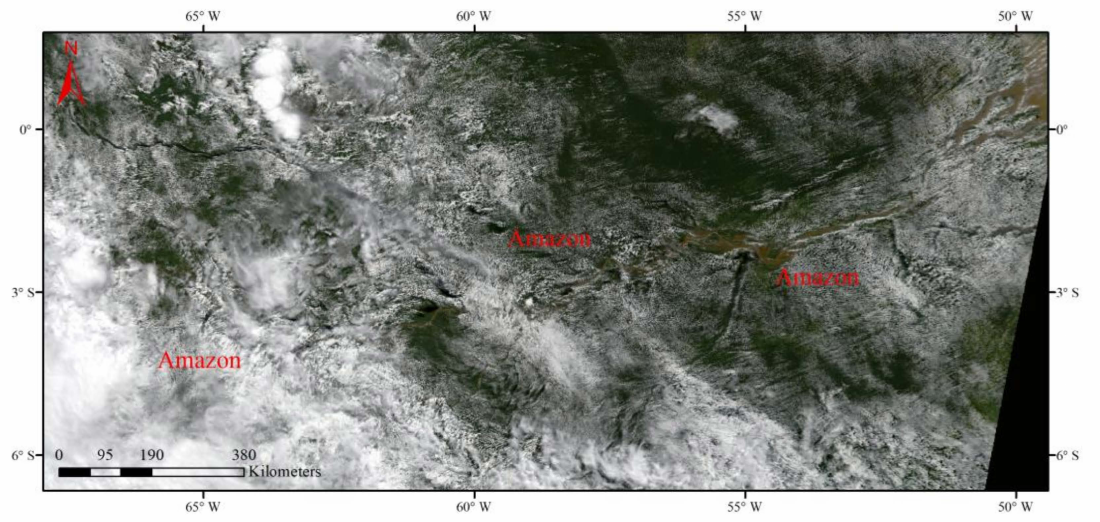
Figure 24. The true-color image of the Amazon on 1 June